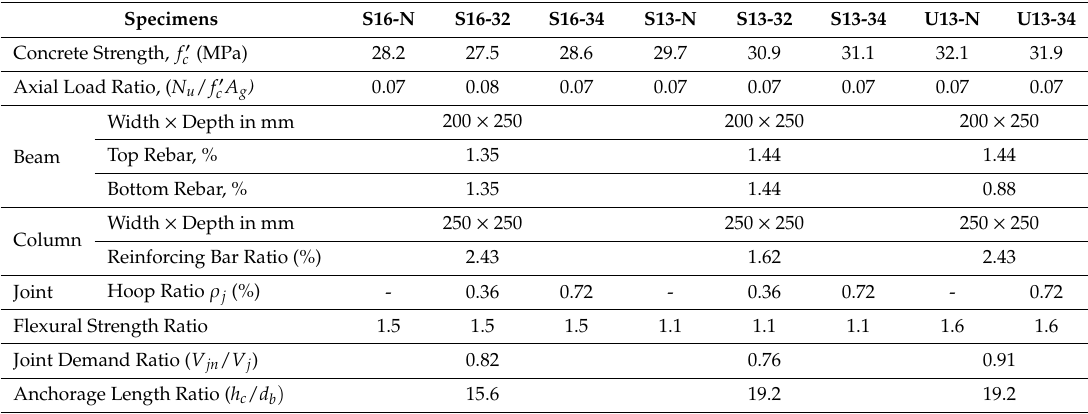
Table 1. Specimen Properties and Test Variables.